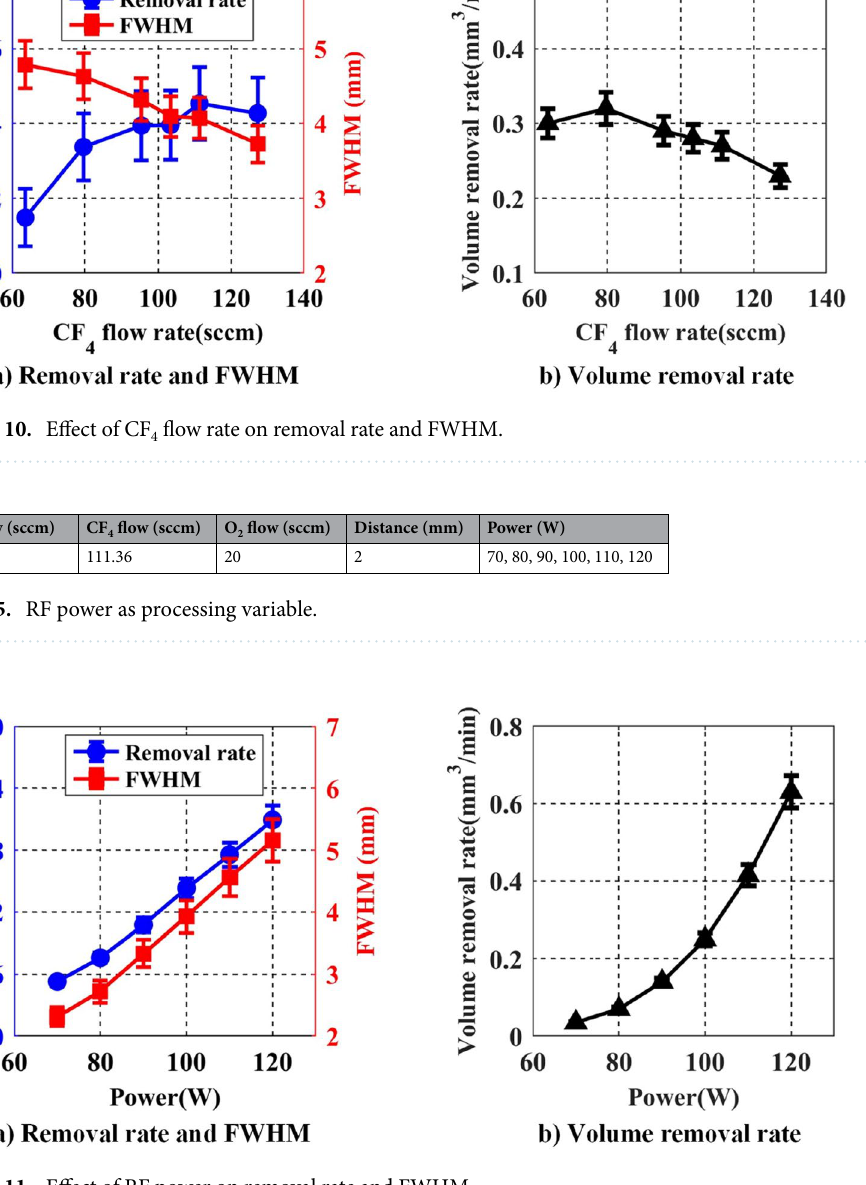
Figure 11. Effect of RF power on removal rate and